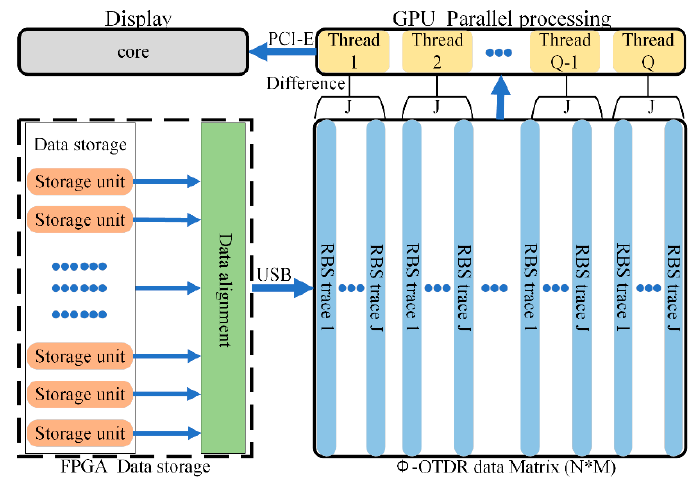
Figure 7. Cooperative data processing with FPGA, GPU and CPU.